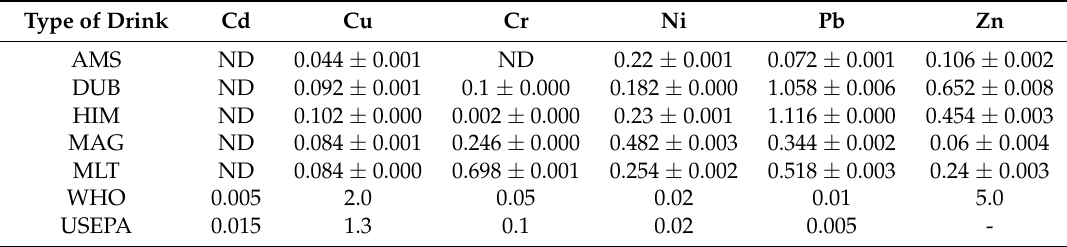
Table 1. Mean Concentration of Trace Metals (mg/L) in Malt